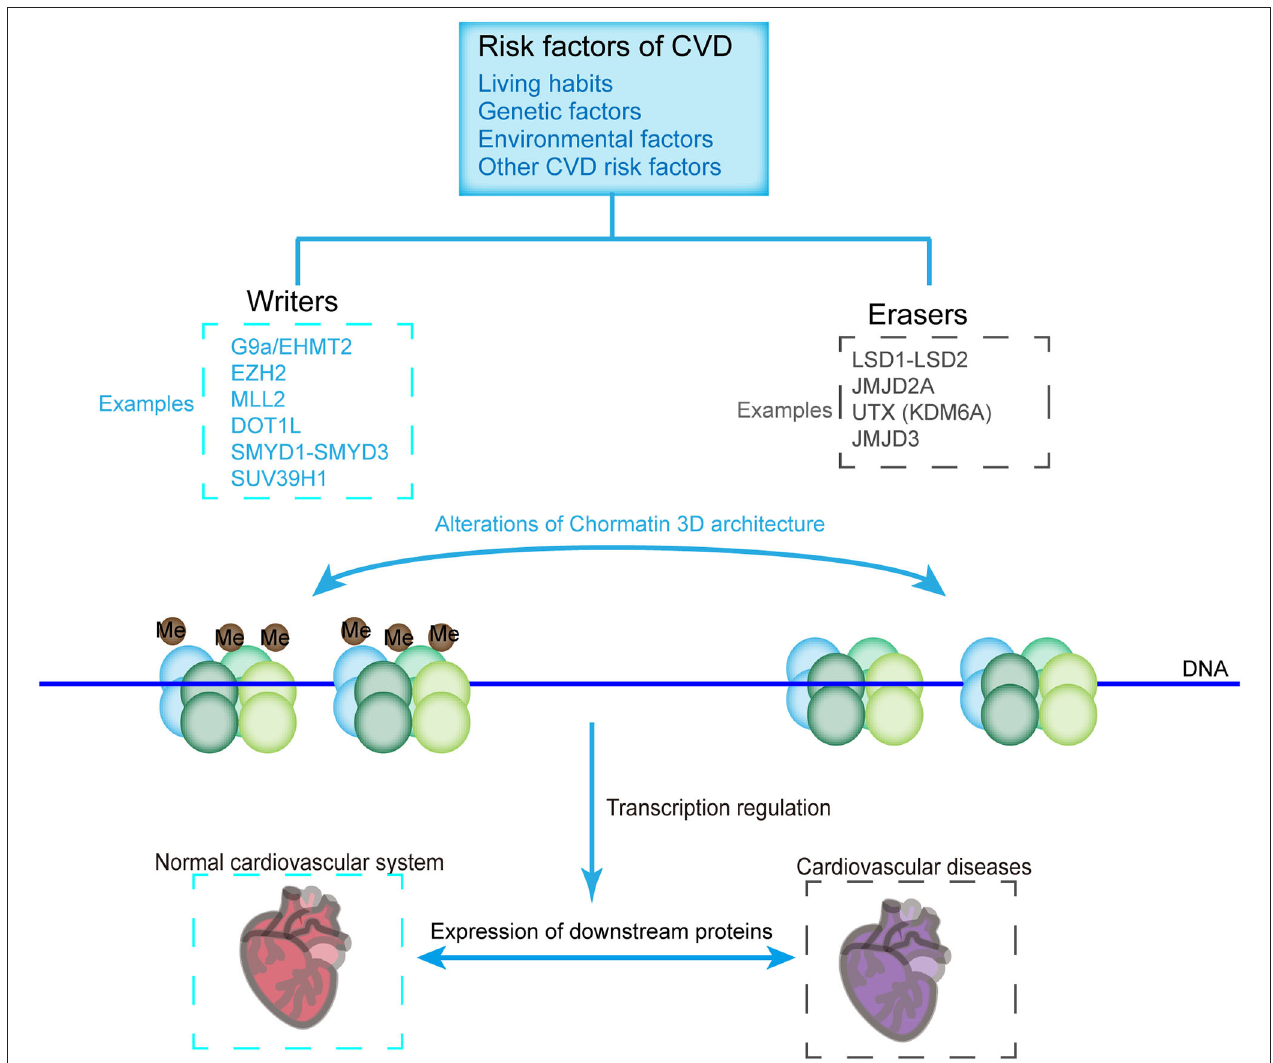
FIGURE 3 | CVD-related histone methyltransferases and demethylases. Chromatin constitutes two structural states, namely, the methylated (Left) and demethylated (Right) states, which are catalyzed by methyltransferases and demethylases, respectively. Histone methylation state affects the loosening of the nucleosome, thus allowing the binding of transcriptional machineries or inhibiting the accessibility of the transcriptional machinery to genes, which are critical for the pathology of CVDs. Methyltransferases and demethylases can be affected by environmental factors, living habits, genetic factors, and other factors of